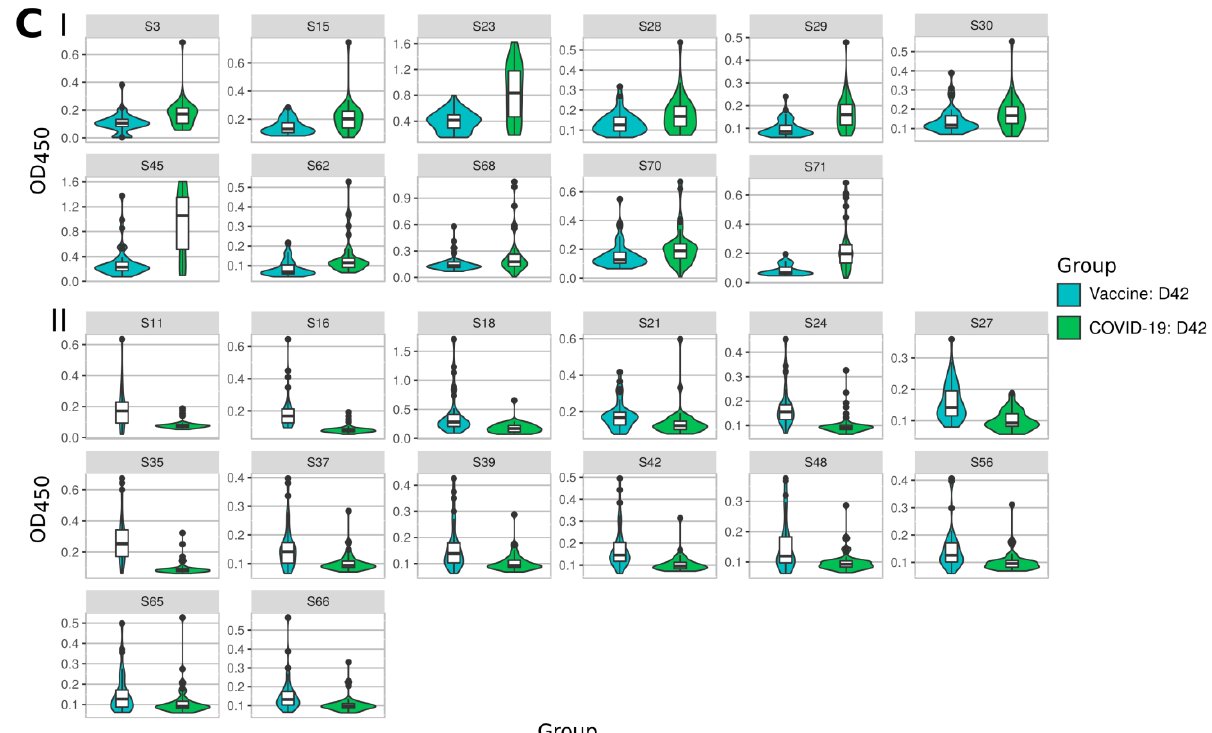
Figure 2. Reactivity to SARS-CoV-2 S protein peptides in SputnikV vaccinated and convalescent sera. Serum samples (40 samples) were collected on D0 and D42 after SputnikV immunization. Serum from convalescent COVID-19 patients (40 samples) was collected between 32 and 65 days after recovery (42.0 ± 11.1 days). Data are presented as Violin plots with boxplots of measured OD650 values. ( A ) SARS-CoV-2 peptide reactivity to sera before (D0) and after (D42) SputnikV vaccination. ( B ) SARS-CoV-2 peptide reactivity to (D0) vaccination and convalescent COVID-19 sera. ( C ) SARS-CoV-2 peptide reactivity between SputnikV vaccinated (D42) and convalescent COVID-19 sera. ( C, I ) reactivity to SARS-CoV-2 peptides was higher in COVID-19 convalescent as compared to vaccinated sera; ( C, II ) reactivity to SARS-CoV-2 peptides was higher in vaccinated as compared to COVID-19 convalescent sera. All presented peptides have statistically significant differences in comparison groups ( p < 0.05, Kruskal – Wallis test).